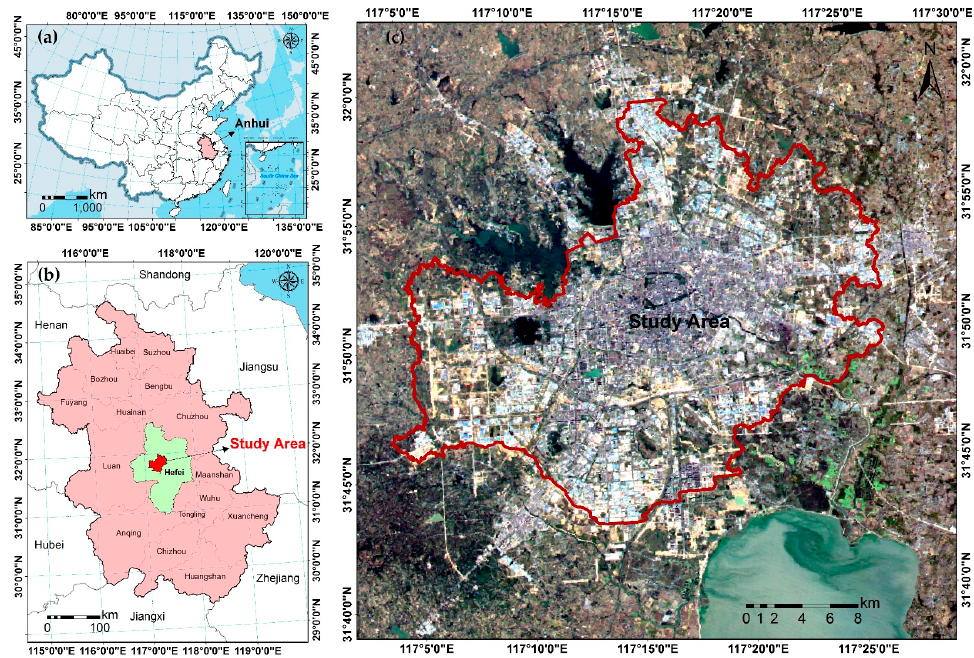
Figure 1. Study area: ( a ) Anhui province in China; ( b ) study area in Anhui’s capital city of Hefei; ( c ) study area highlighted in red in the true color composite of HJ-1A satellite imagery (13 October 2013).